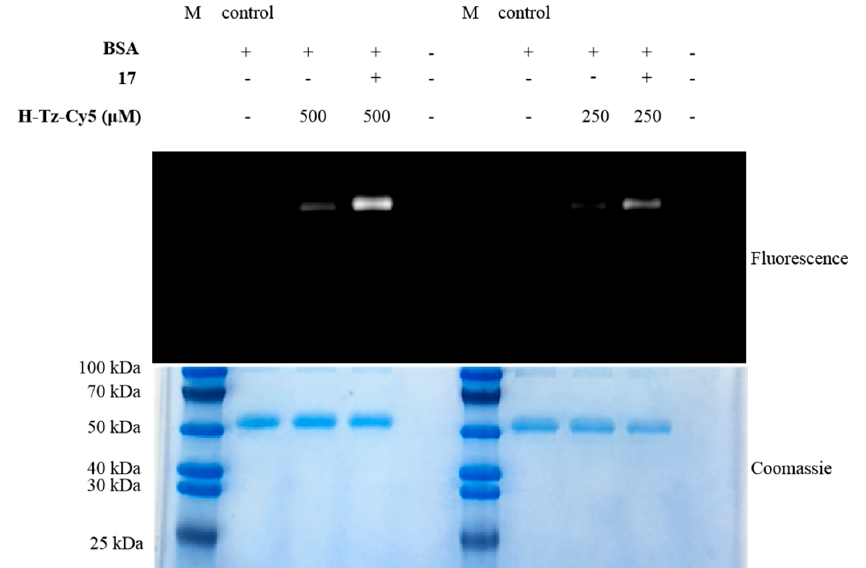
Figure 3. In vitro labeling of bovine serum albumin (BSA) via cyclobutene–tetrazine bioorthogonal reaction. Upper panel : fluorescent image of the same gel before Coomassie blue staining. Lower panel : Coomassie-blue-stained gel of BSA modified through IEDDA reaction between conjugate 17 and the Cy5-containing fluorescent probe 19 (250 µ M or 500 µ M). Control reactions contained only BSA or BSA with only the Cy5 probe (250 µ M or 500 µ M). “M”: protein